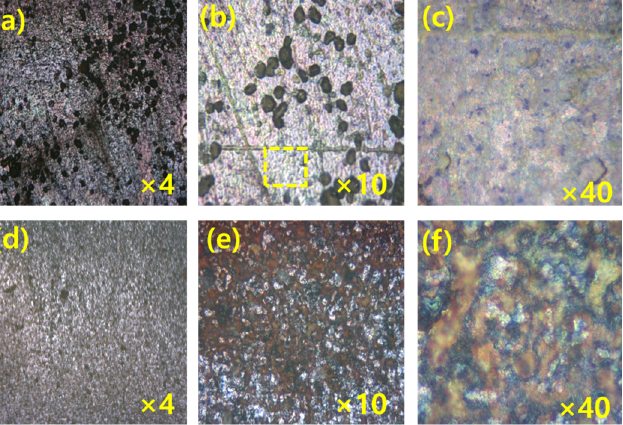
Figure 7. The MS surface images ( a – c ) after 1 h dipping, and ( d – f ) after 3 h dipping at 25 °C in the solution of 1000 ppm green inhibitor at different magnifications.